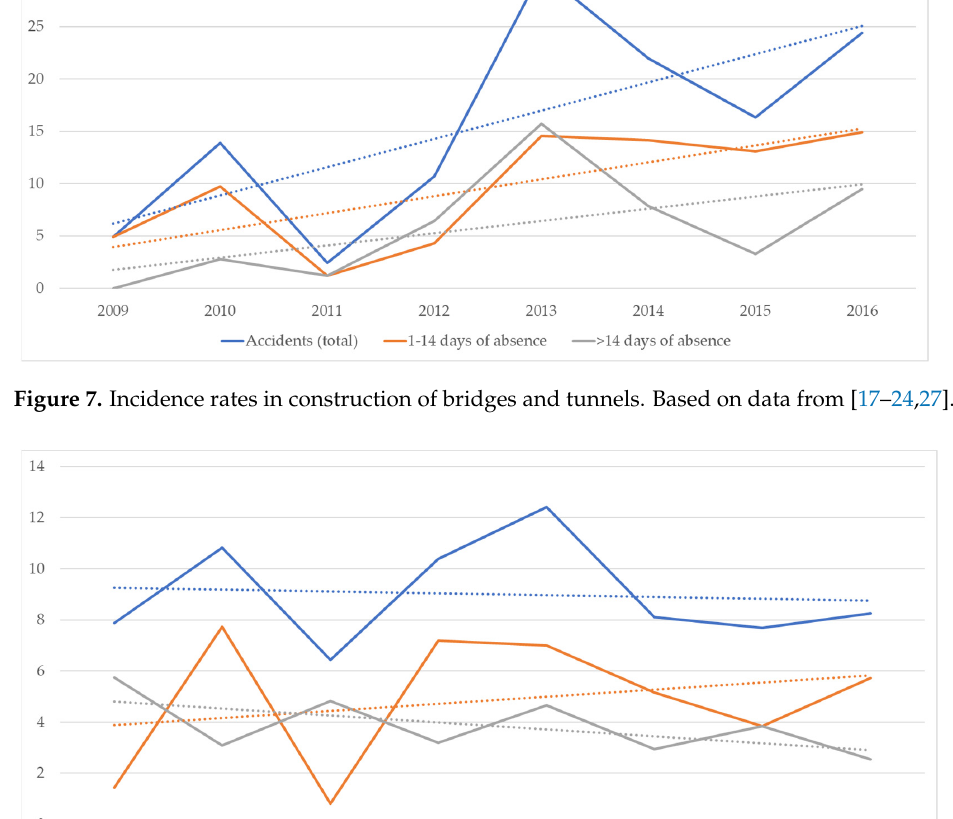
Figure 8. Incidence rates in construction of water projects/construction of other civil engineering projects n.e.c. Based on data from [17 – 24,27] .